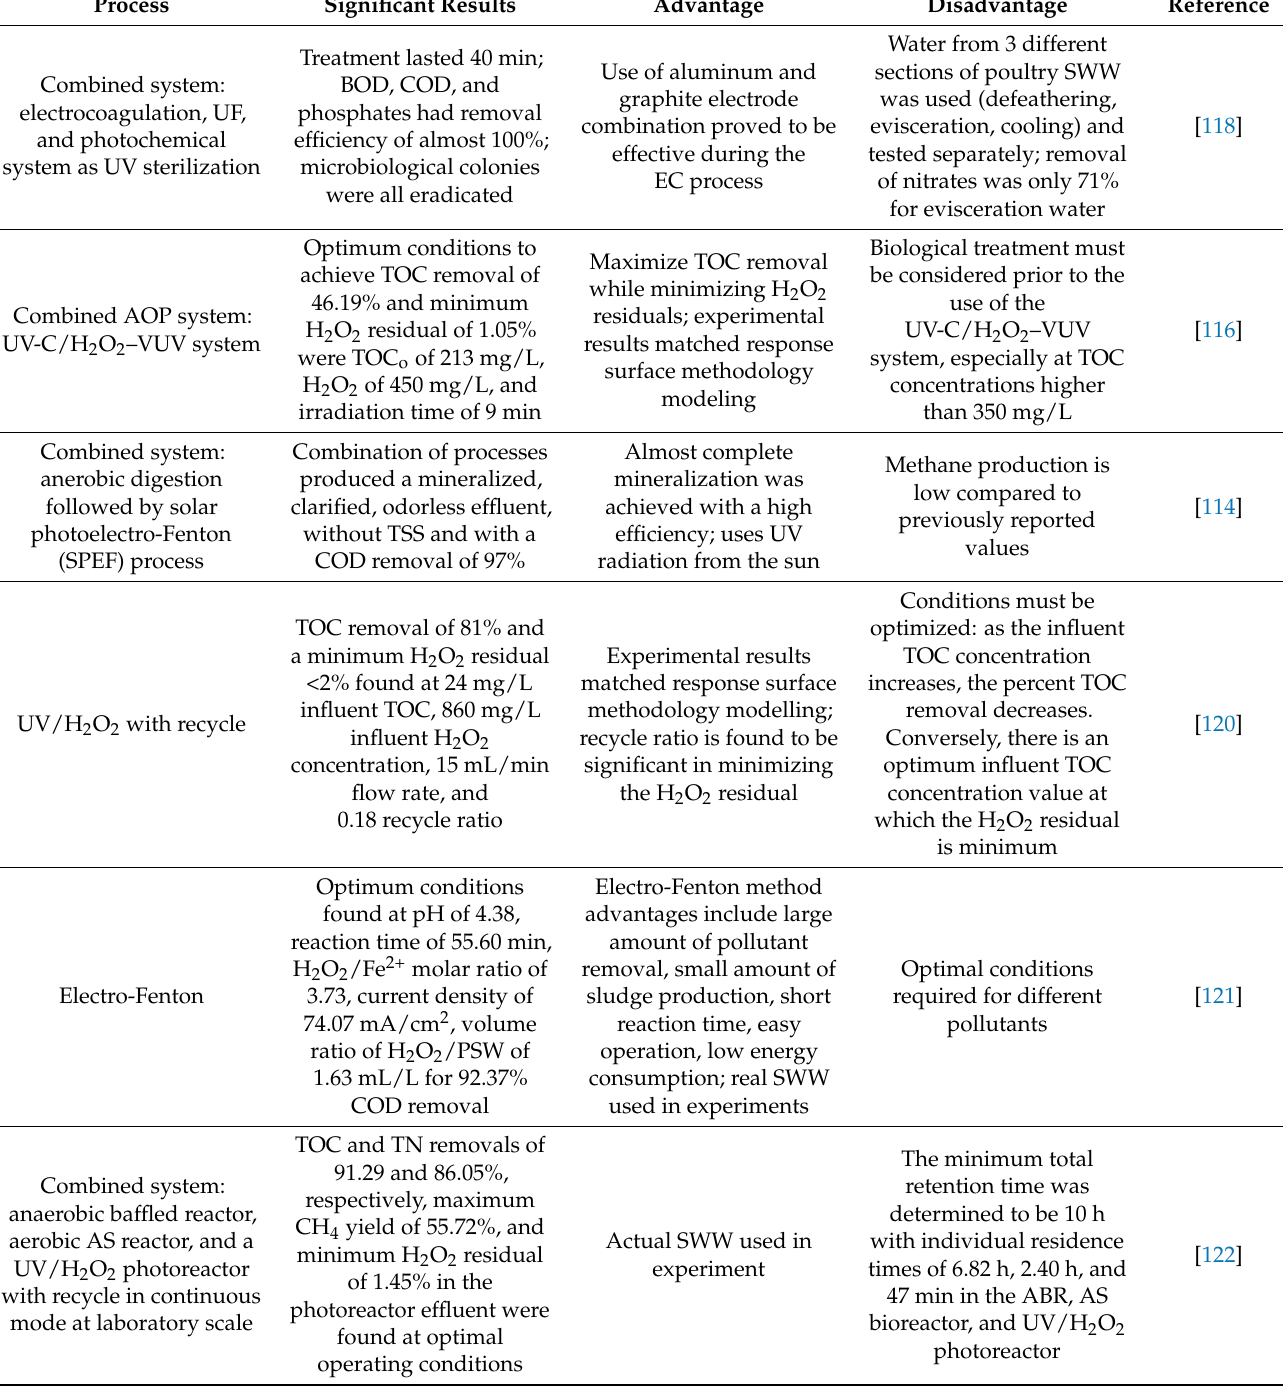
Table 5. AOPs/Combined treatments. Abbreviations for common terms in table